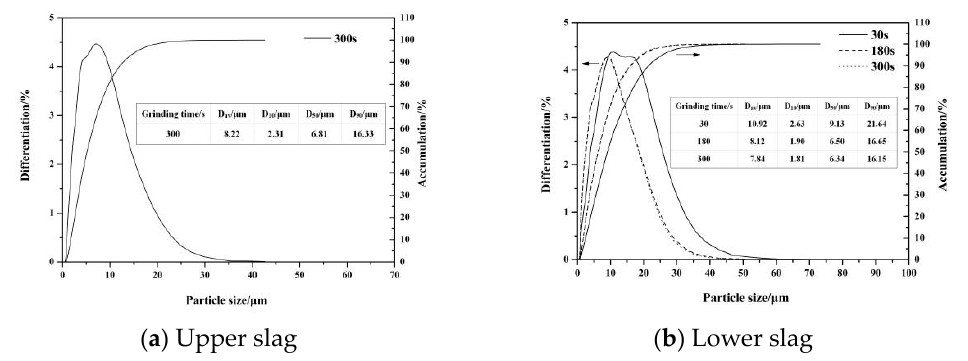
Figure 5. Particle size distribution of the upper and lower modified slags with different grinding times.